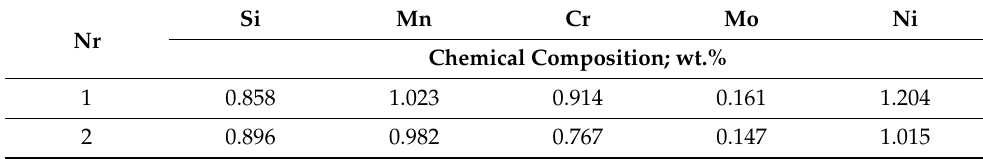
Table 6. Chemical composition of the tested